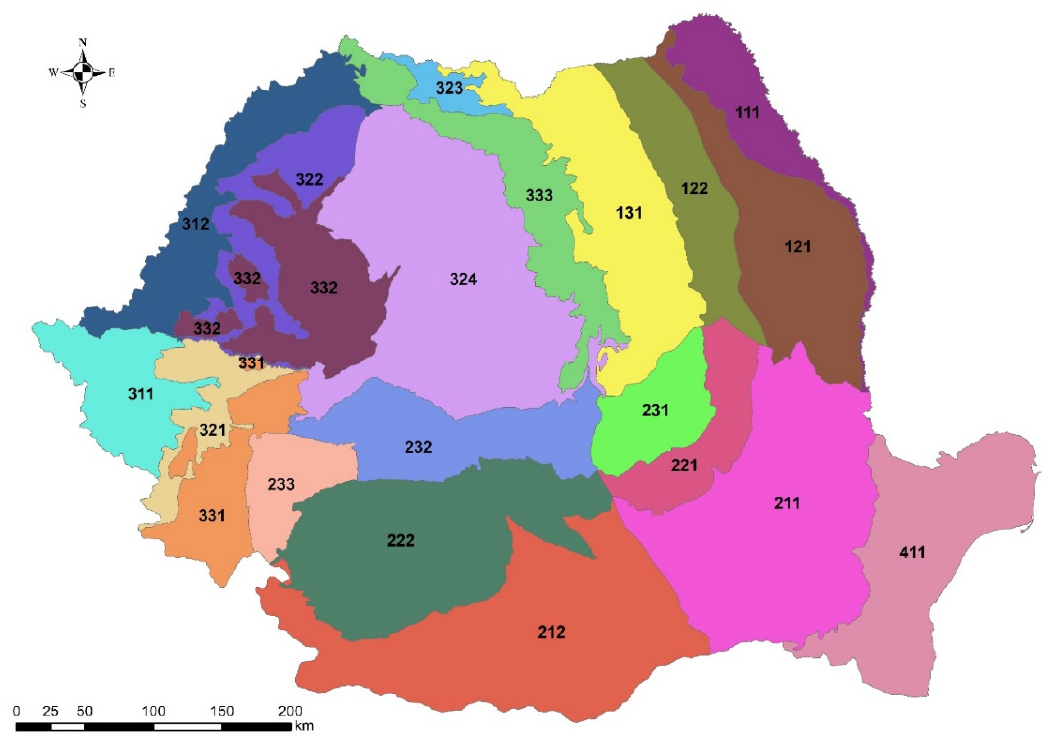
Figure 2. Romanian ecoregions delineated according to spatial contiguity, geology, soils, and geomorphology maps of the Romanian Academy [16].